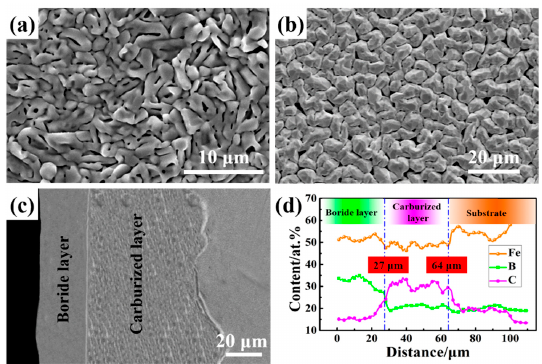
Figure 2. SEM images of the borocarburized layer ( a ) C deposition, ( b ) B deposition, ( c ) cross-section image ( d ) EDS result.